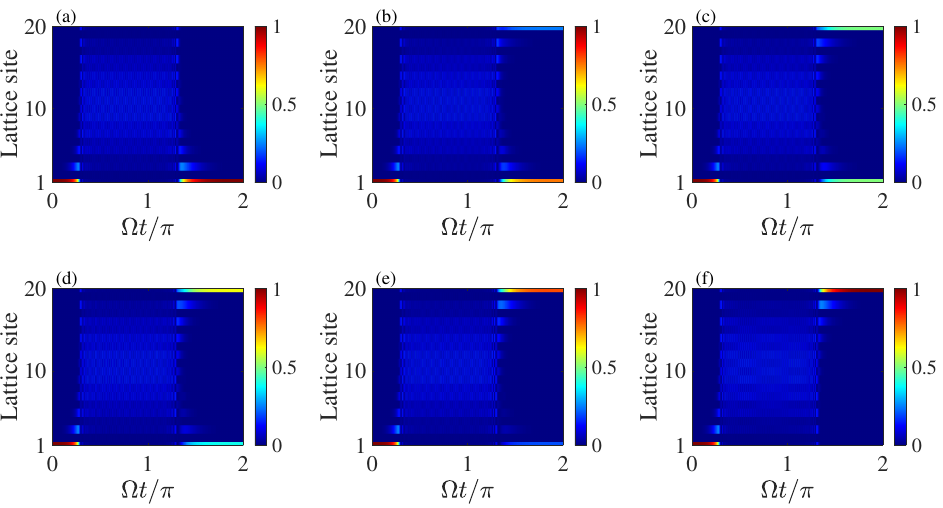
Figure 5. The topological beam splitter (TBS) with different splitting proportions when Ω takes different values. ( a ) 100%:0% TBS with Ω = 0.004530. ( b ) 75%:25% TBS with Ω = 0.004538. ( c ) 50%:50% TBS with Ω = 0.0045422. ( d ) 40%:60% TBS with Ω = 0.004544. ( e ) 20%:80% TBS with Ω = 0.0045473. ( f ) 0%:100% TBS with Ω = 0.004554. Other parameter takes N =